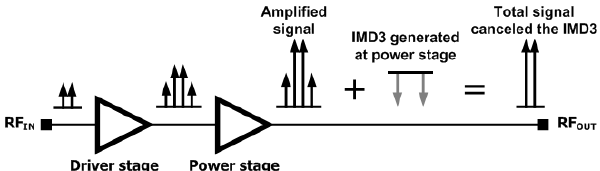
Figure 1. Principle of third-order intermodulation distortion (IMD3) cancellation in the antiphase technique.